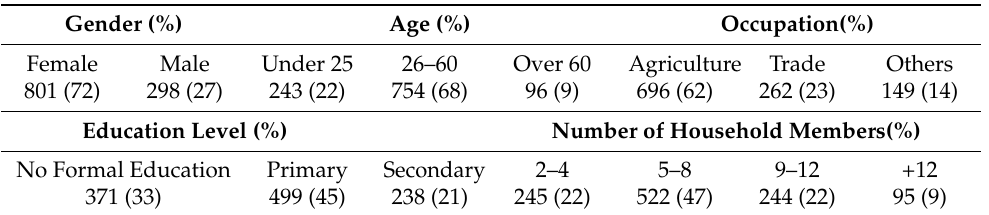
Table 5. Socio-demographic characteristics of the study sample (N = 1109).